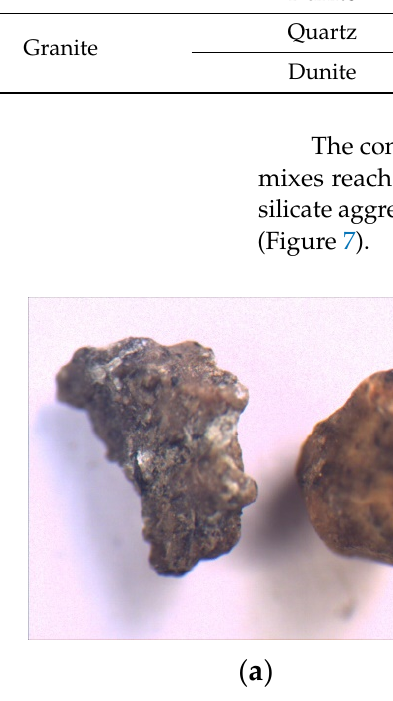
Table 5. Compressive strength of the concrete samples.